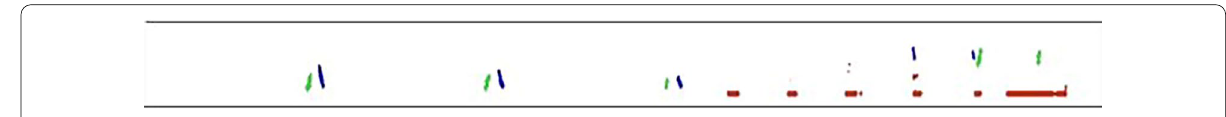
Figure 12 Ultrasound image in rail